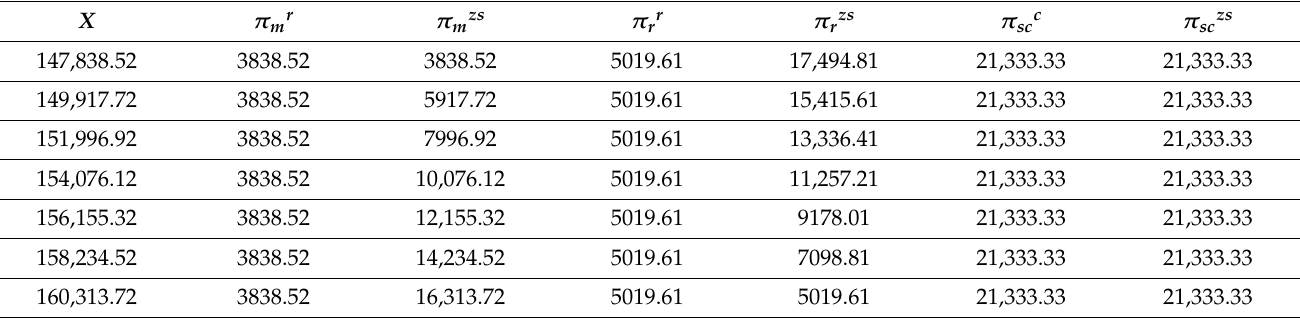
Table 2. Profits change with X .